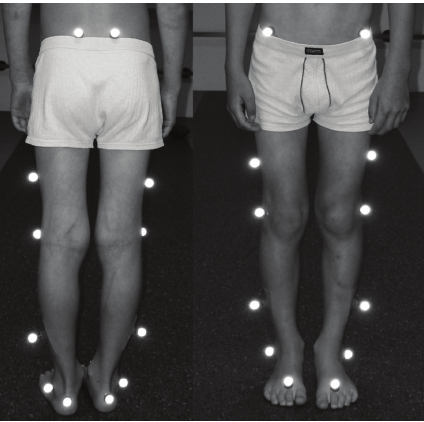
Figure 1: Placement of the Plug-in-Gait